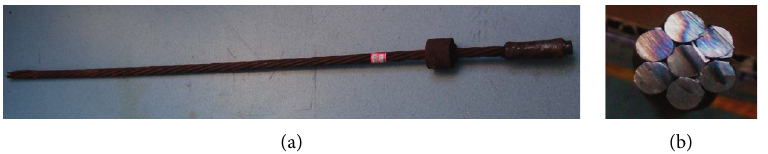
Figure 6: Morphology of the broken anchor cable: (a) longitudinal morphology; (b) transverse section morphology.